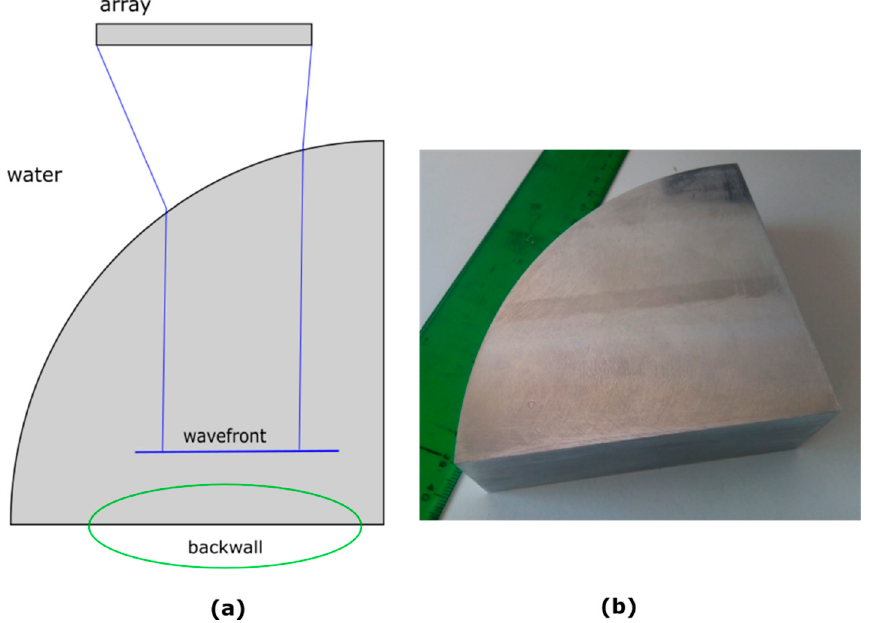
Figure 6. ( a ) Schematic of the experimental setup. ( b ) Test piece.